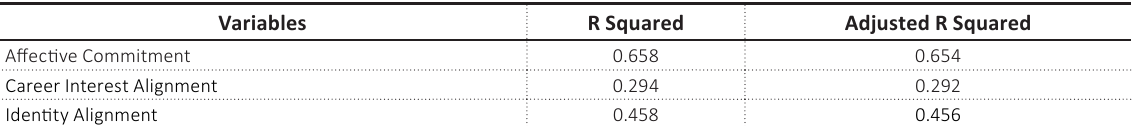
Table 5. R Squared (R 2 )